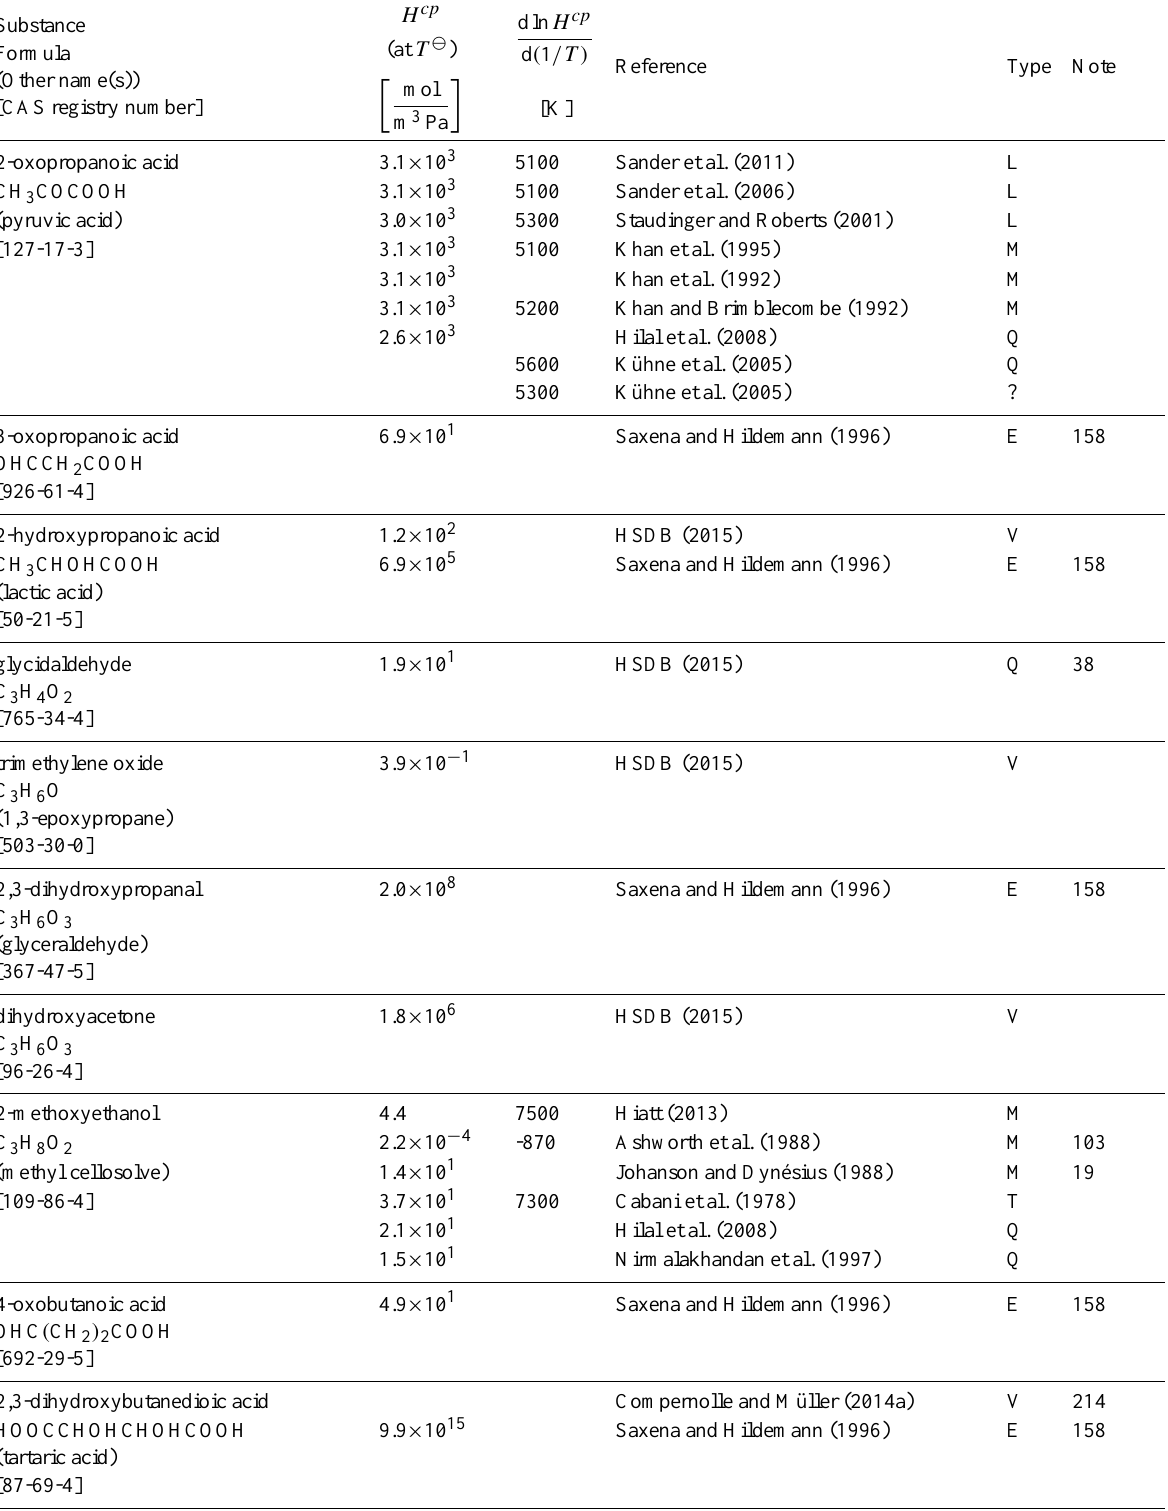
Table 6: Henry’s law constants for water as solvent